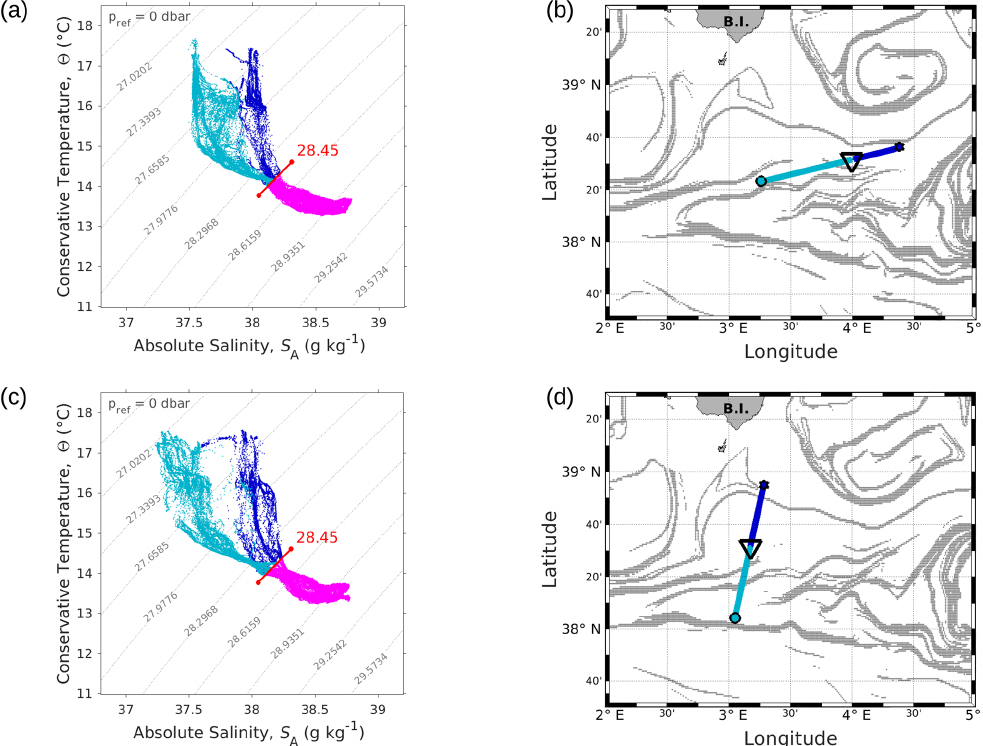
Figure 4. (cid:50) – S A diagrams of data collected along the WE (a) and the NS (c) transects. The younger AW is represented in light blue and the older AW in dark blue. Intermediate water is also represented in pink. The isopycnal 28.45kgm − 3 , separating surface waters from the deeper ones, is highlighted in red. Triangles in panels (b) and (d) indicate the geographical position of the separation between the two types of AW along the corresponding